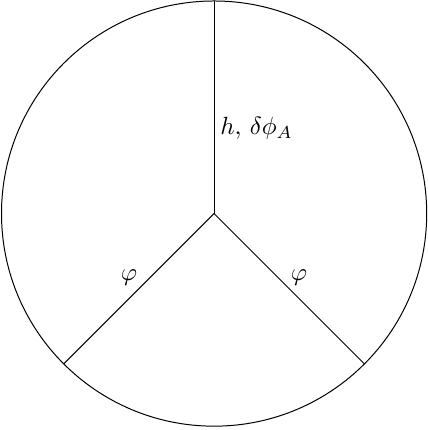
Figure 2 . Exchange diagrams for three point